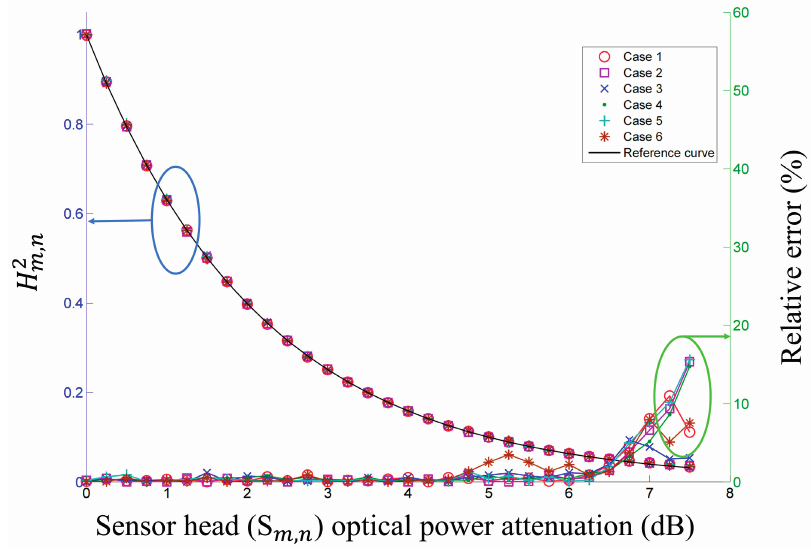
Figure 4. Measured (cid:1834) (cid:3040),(cid:3041)(cid:2870) (left) and relative error (right) versus sensor head optical power attenuation of six cases from Table